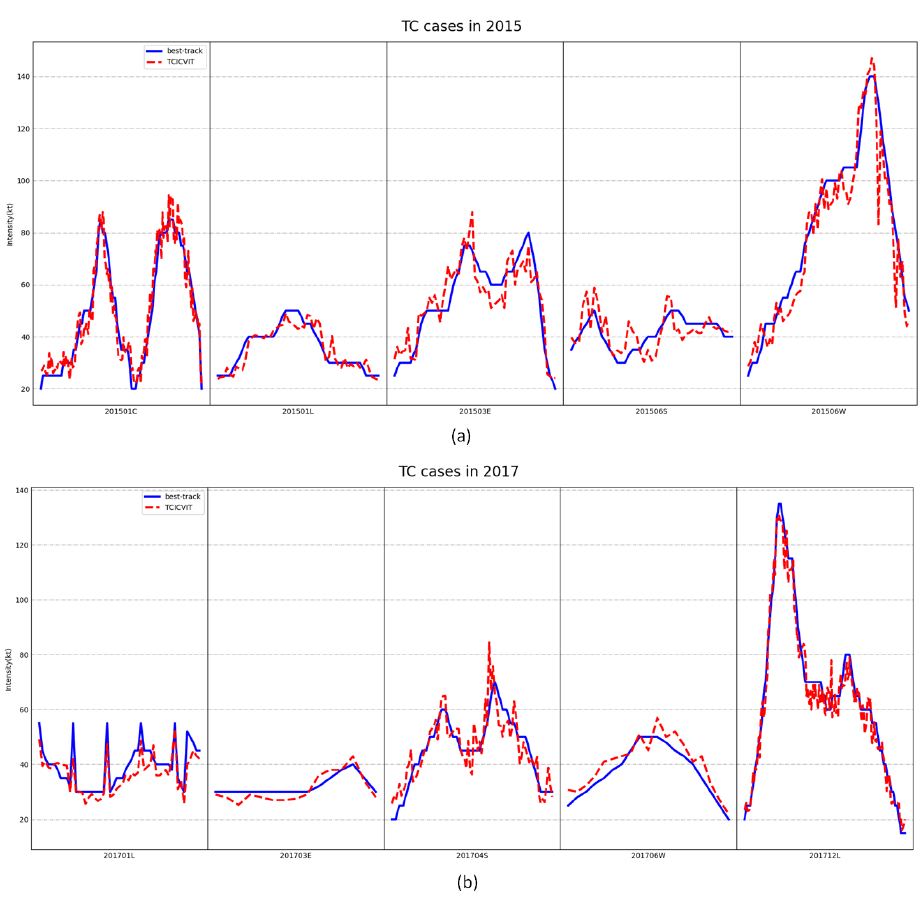
Figure 8. TC cases in 2015 and 2017, with the intensity on the y-axis and the TC names on the x-axis. The blue line represents the best track, and the red line represents the TCICVIT model